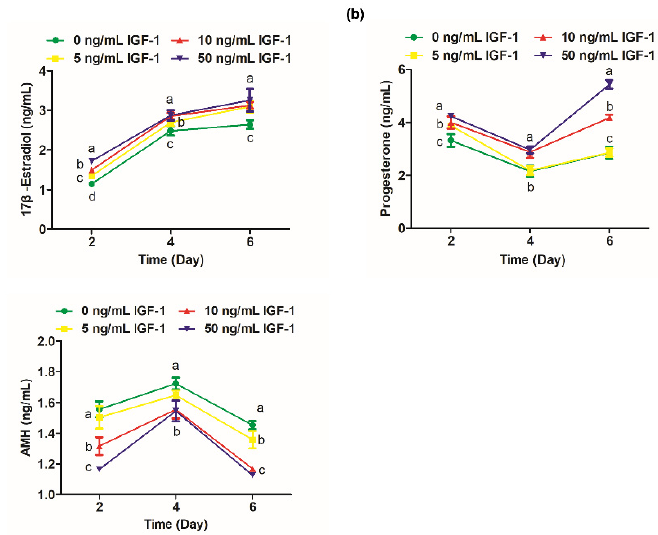
Figure 3. Effect of IGF-1 on hormone secretion of in vitro cultured follicles. ( a ) The secretion of 17 β -estradiol; ( b ) progesterone and ( c ) AMH at days 2, 4, and 6. Error bar: standard deviation; points with completely different letters (a, b, c) indicating significant difference among treatments for isolated time points ( p < 0.05). n = 10 follicles for three replicates.